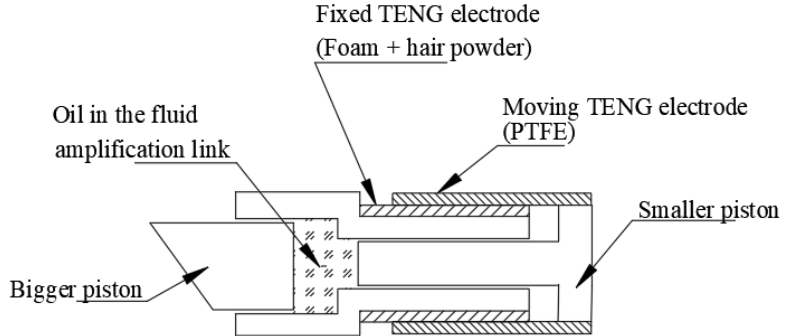
Figure 20. Details of the TENG in the in ‐ shoe sensor.